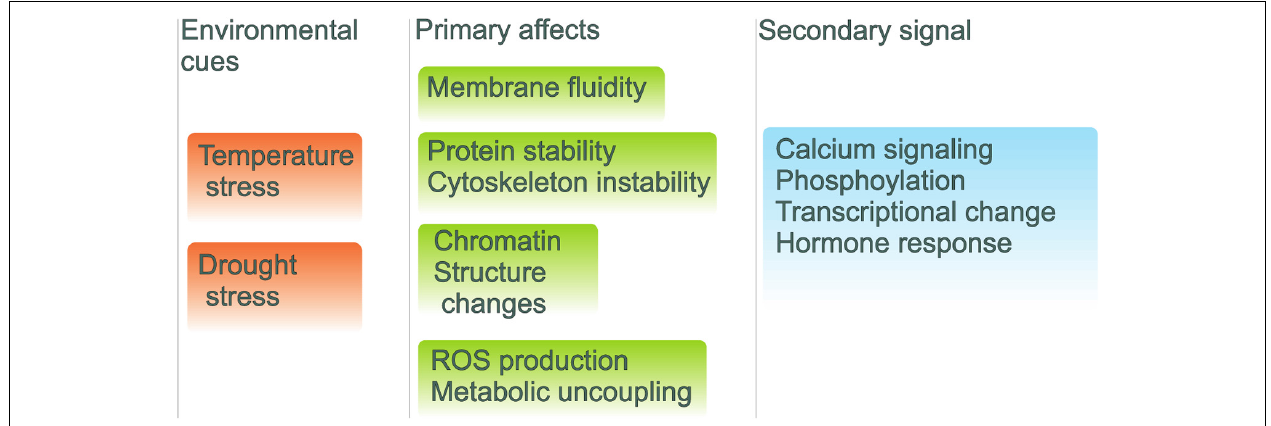
FIGURE 2 | Environmental signaling pathways with external cues and internal repercussions. Environmental cues are on the left in red backgrounds with initial cellular effects with green backgrounds and the organismal signals are shown with blue background.